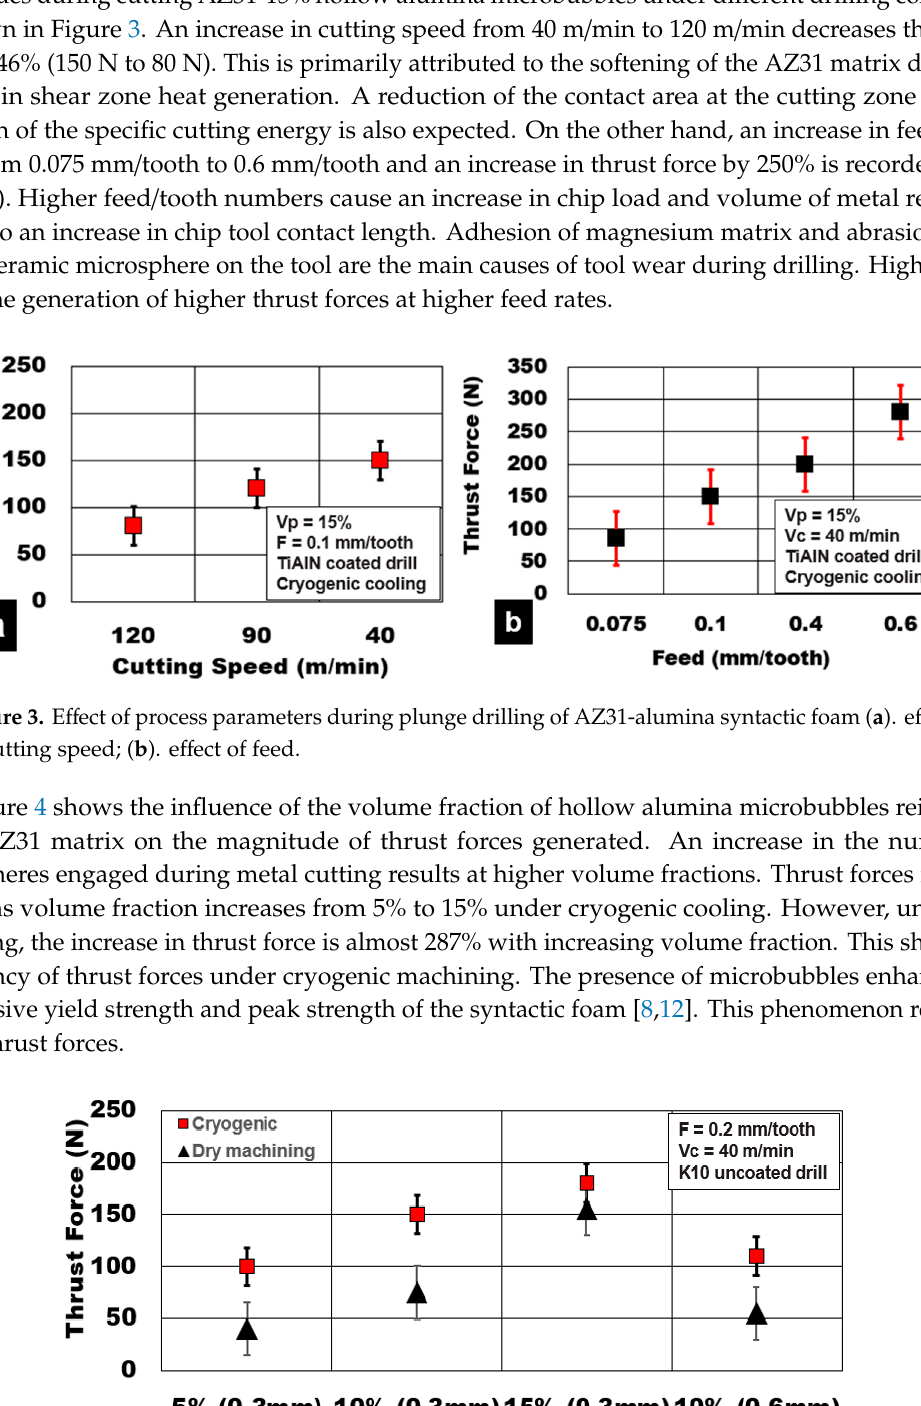
Figure 4. Effect of hollow microsphere volume fraction and average size on thrust force during plunge drilling of AZ31-alumina syntactic foam.